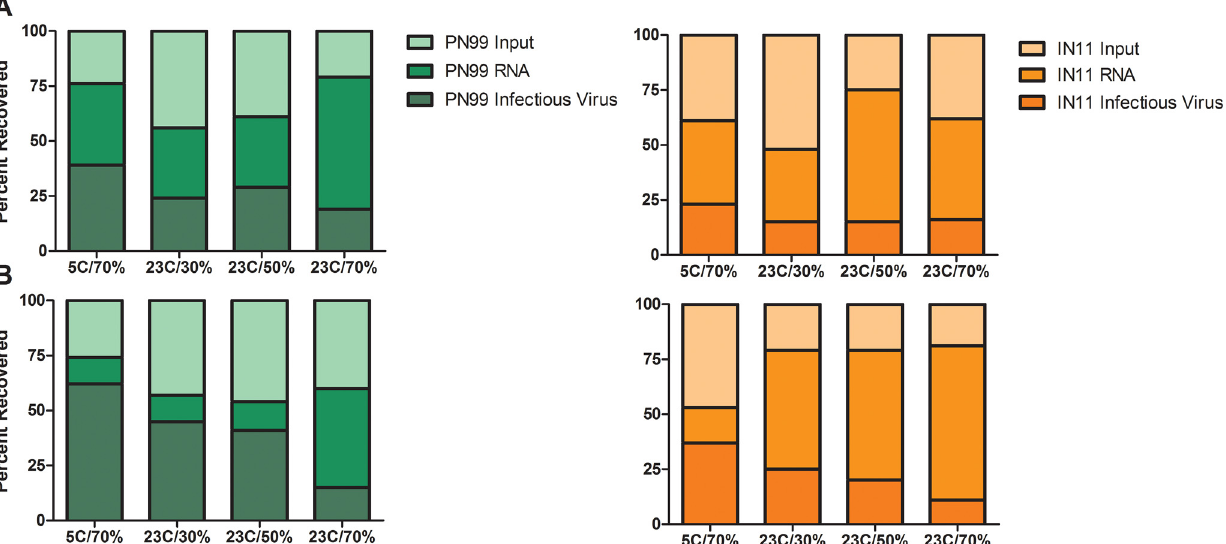
Fig 7. Recovery rates of influenza virus subjected to the aerosol collection procedure. Prepared impactor plates were spiked with 10 2 – 10 3 pfu of PN99 (green) or IN11 (orange) influenza virus and were placed at a designated environmental condition as shown on the x-axis while air was pulled through them for 15 minutes (A) or 5 minutes (B). Experiments were performed in duplicate and the percentage of recovered RNA was determined by real time RT-PCR using M gene primers and infectious virus recovery was based on plaque assays. Each shaded section represents the proportion of the total amount of input virus that was